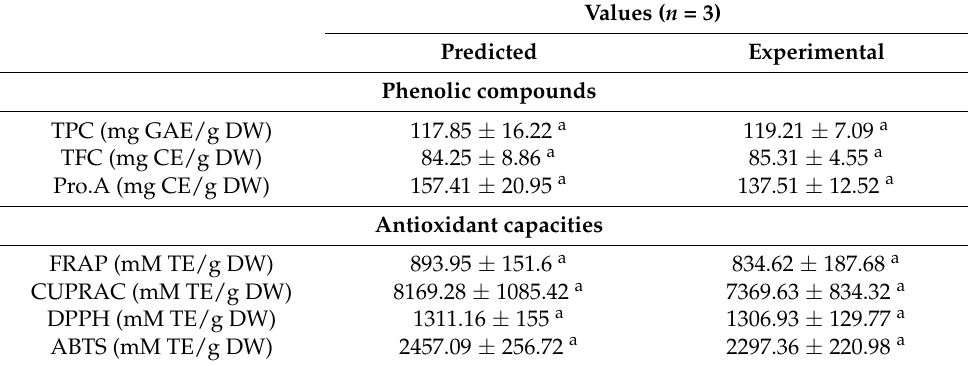
Table 3. Justification of the predicted yields of phenolics and antioxidant